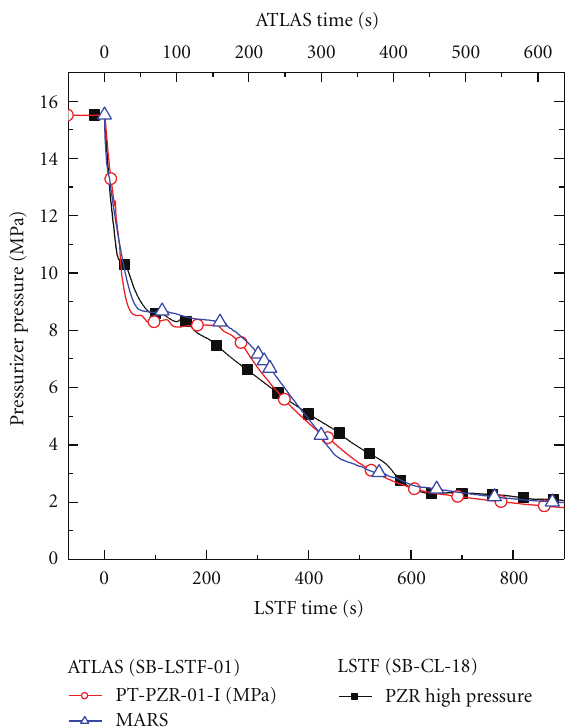
Figure 21: Comparison of the primary pressure in the LSTF coun- terpart